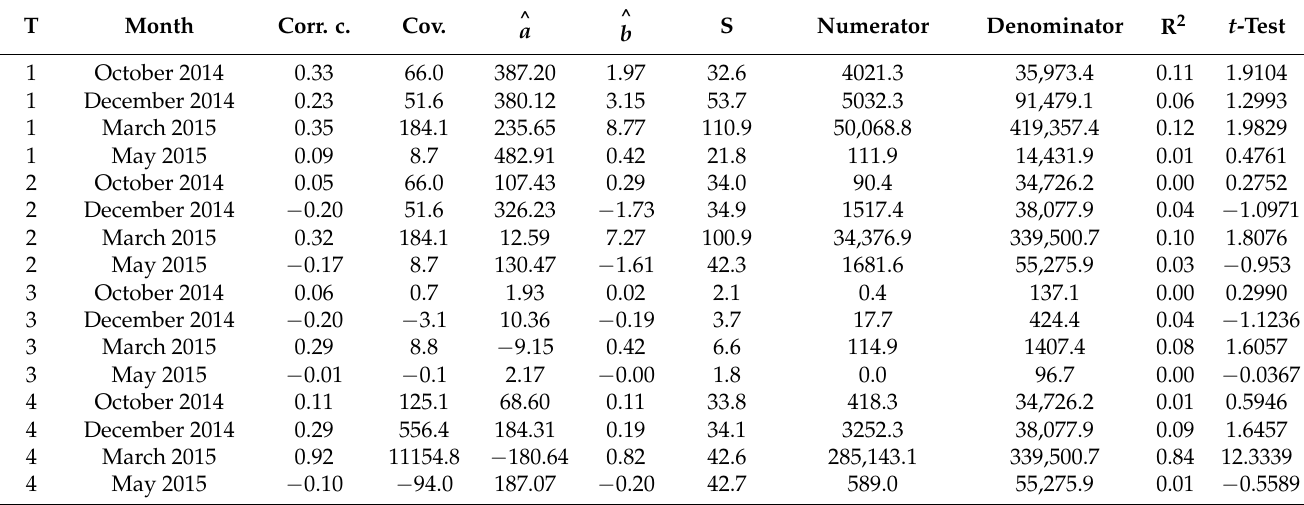
Table 7. Sample of output data from the correlation analysis